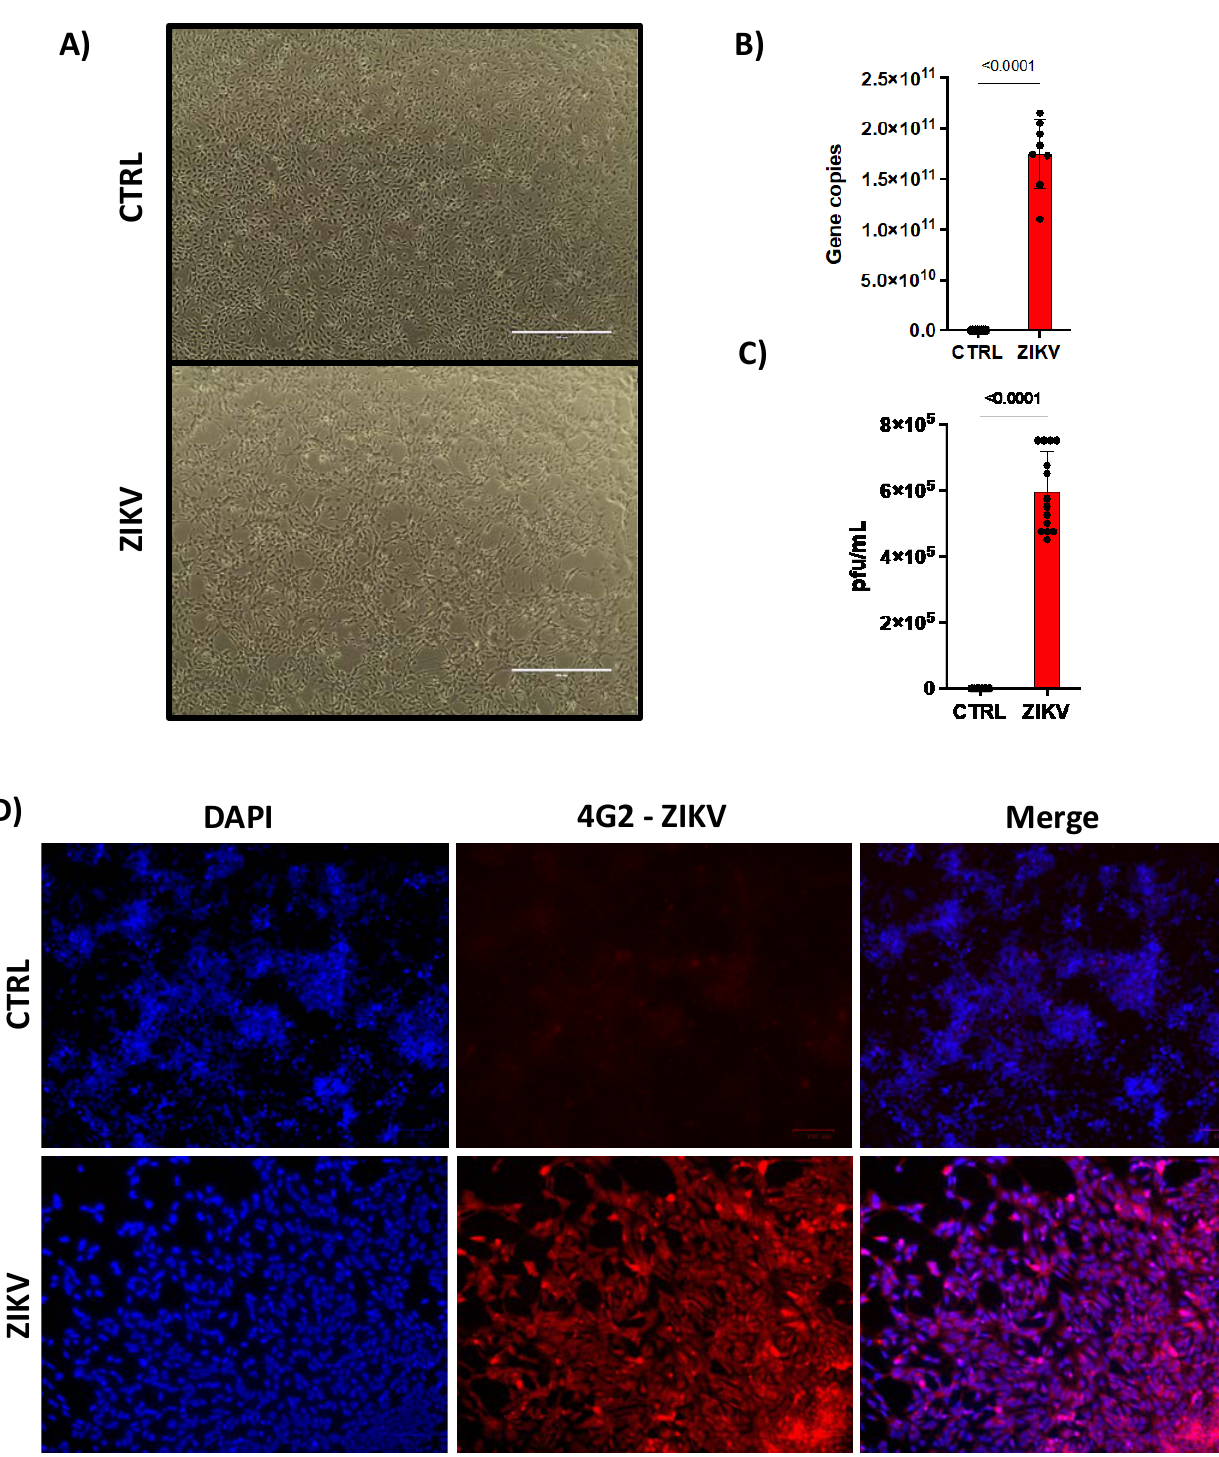
Figure 1. ZIKV infects human NPCs. Human NPCs were ( A ) infected or not with ZIKV (MOI = 1). 10 × magnification. After 48 h post infection, they were evaluated for ( B ) viral copy numbers by qPCR (n = 14) and ( C ) PFU. (n = 8). In ( D ) ZIKV infection was confirmed by immunofluorescence with anti-envelope flavivirus antibody at 20 × magnification (n = 3). Graphs represent three independent experiments. Unpaired t